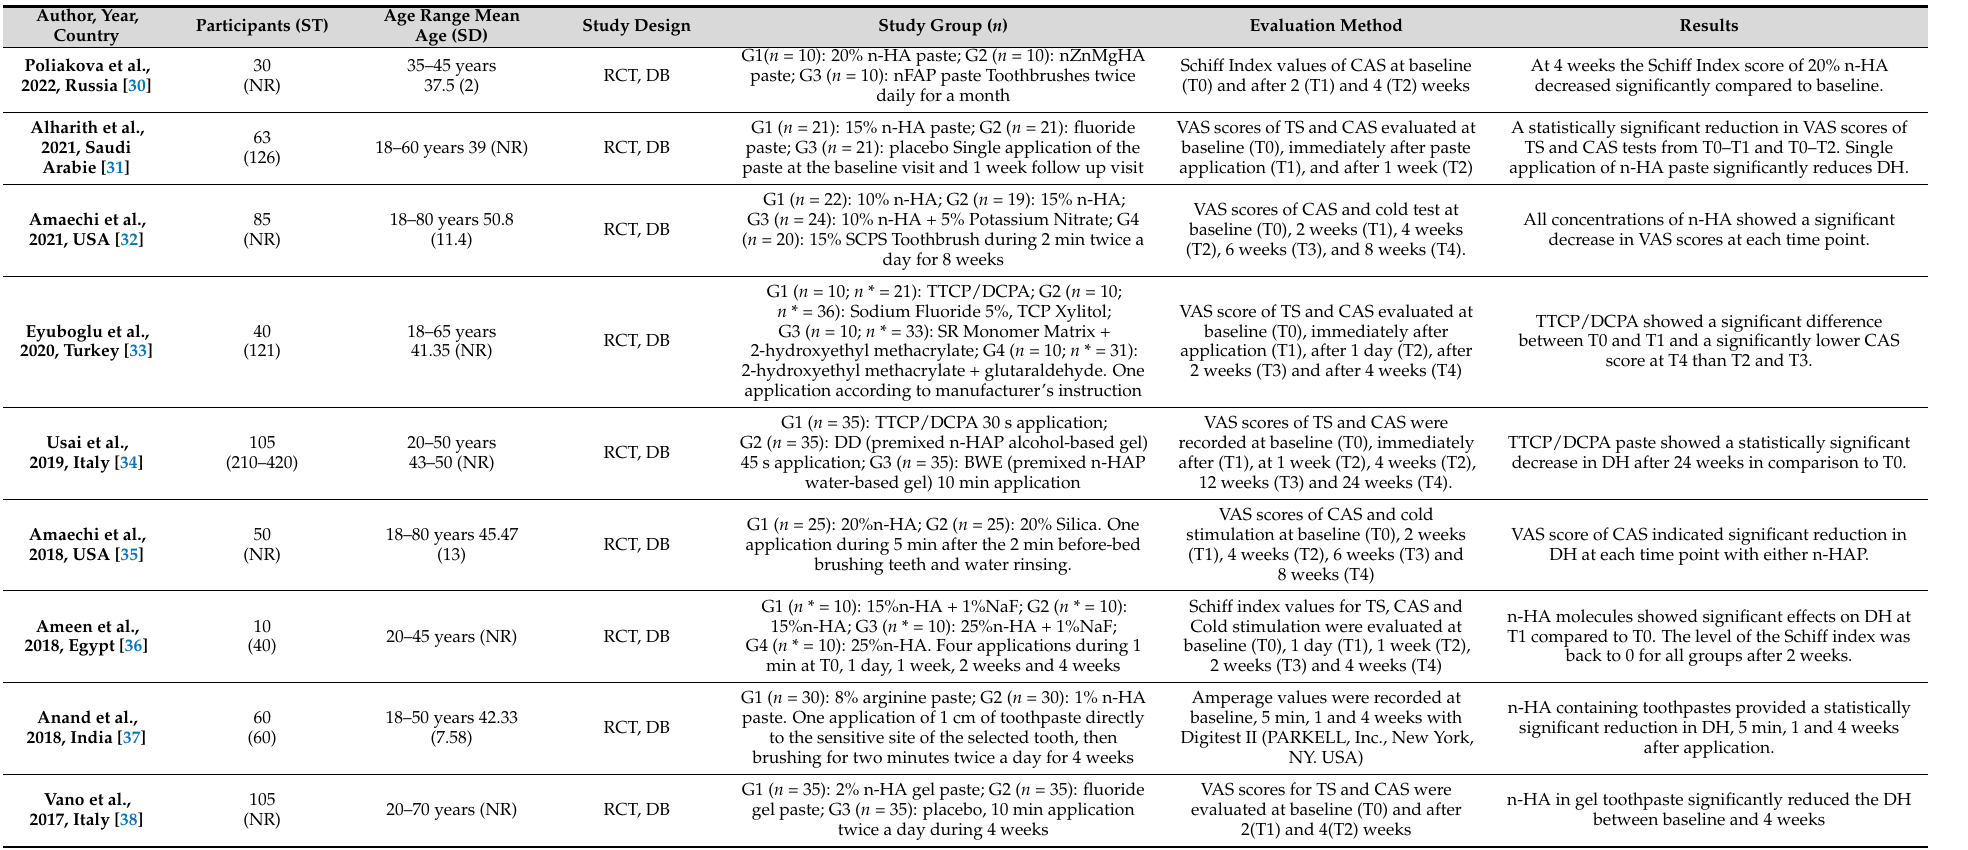
Table 2. Studies included in quantitative